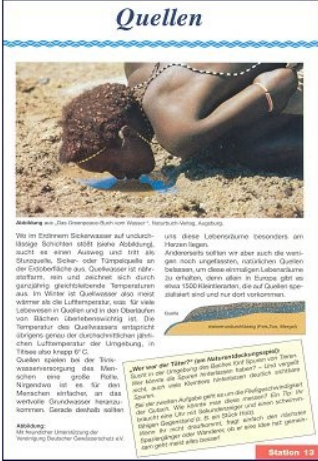
Figure 8. Station clearly too high for the target group of children (Spring Experience Trail, Stock- ach, Germany) (Megerle 2001).